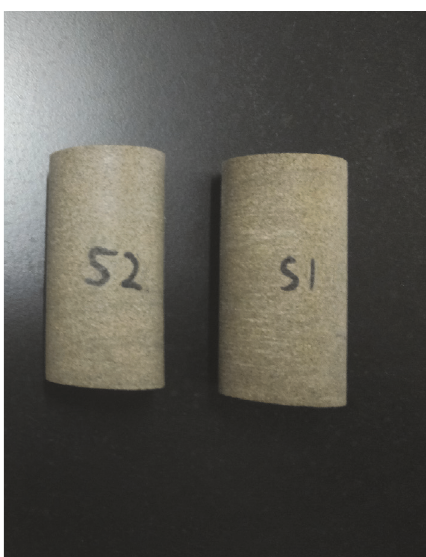
Figure 1: Rock samples.